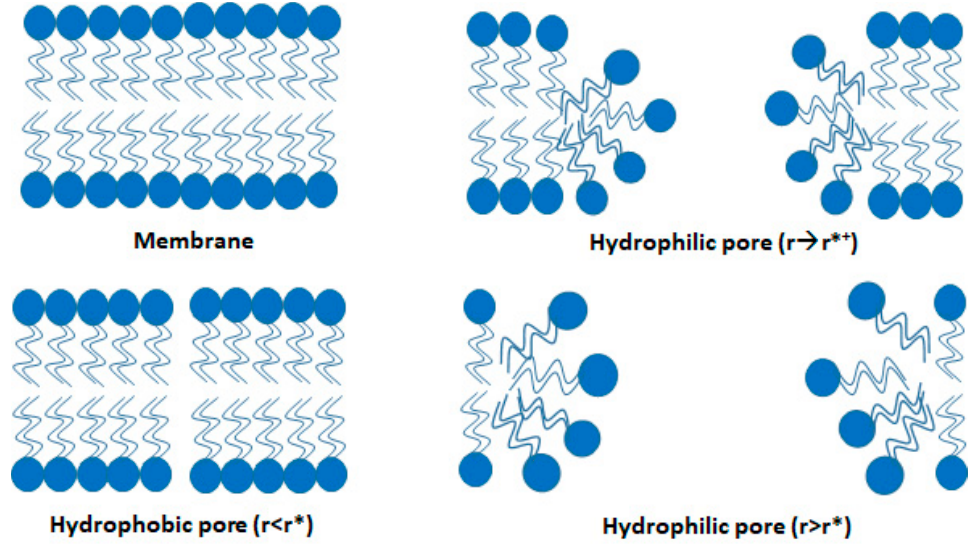
Figure 7. Rearrangement in the structure of the lipid bilayer membrane during electroporation. Figure has been redrawn from ref. [45].